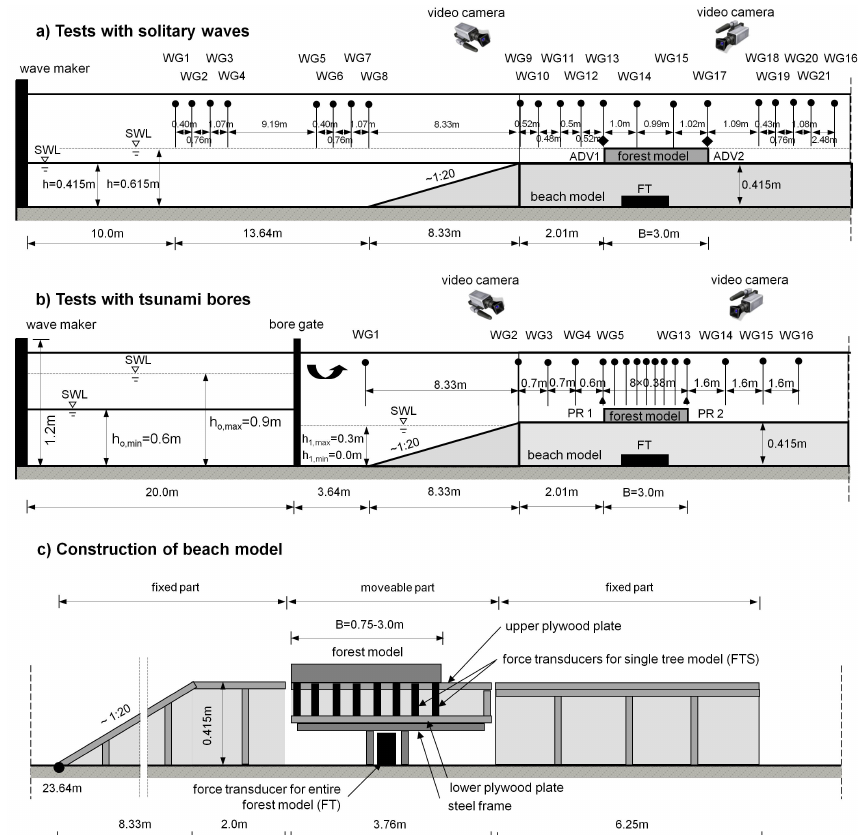
Fig. 5. A schematic view of exemplary experimental model set-up with forest model of width of B = 3.0m: (a) in experiments with solitary waves, (b) in experiments with tsunami bores, (c) construction details of beach model (ADV – acoustic Doppler velocimeter, FT – transducer measuring forces exerted on entire forest, FTS – transducer measuring forces exerted on single mangrove model, PR – micro-propeller-type current meter, WG – wave gauge). Arrangement of force transducers measuring forces exerted on single tree models is provided in Fig. 6 and Table